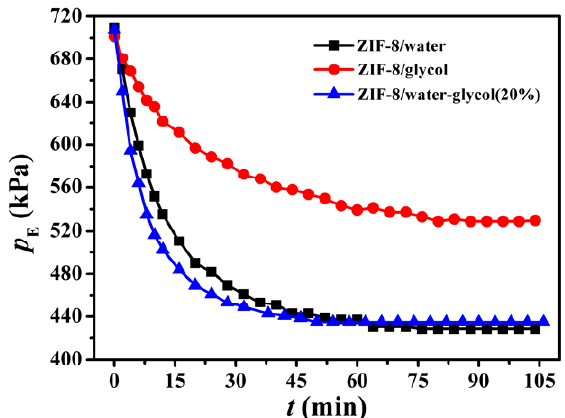
Figure 6. Kinetic curves for the ZIF ‐ 8 slurry containing different liquid media at 293.15 K and fixed initial pressure of 700 kPa. The solid content of ZIF ‐ 8 is 20 wt % for each slurry. The mass ratio between water and glycol in the ZIF ‐ 8/water ‐ glycol slurry is specified to 4:1.